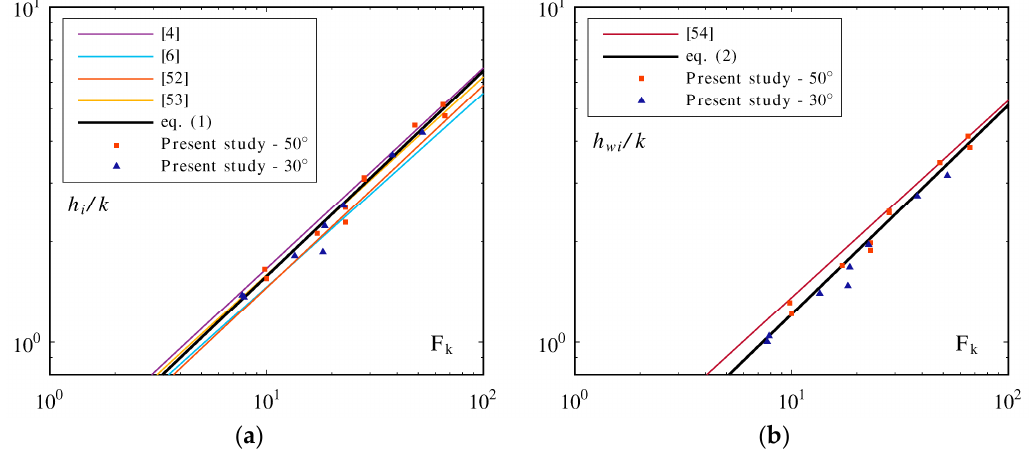
Figure 3. Inception point ( a ) mixture flow depth h i , and ( b ) equivalent blackwater flow depth h wi .